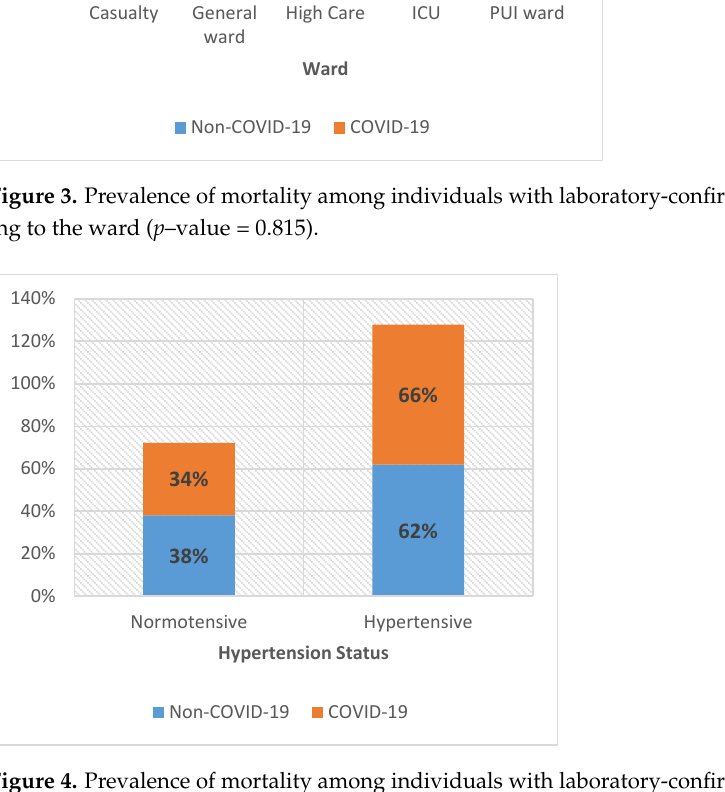
Figure 4. Prevalence of mortality among individuals with laboratory-confirmed SARS-CoV-2 ac- cording to hypertension status ( p -value = 0.510).